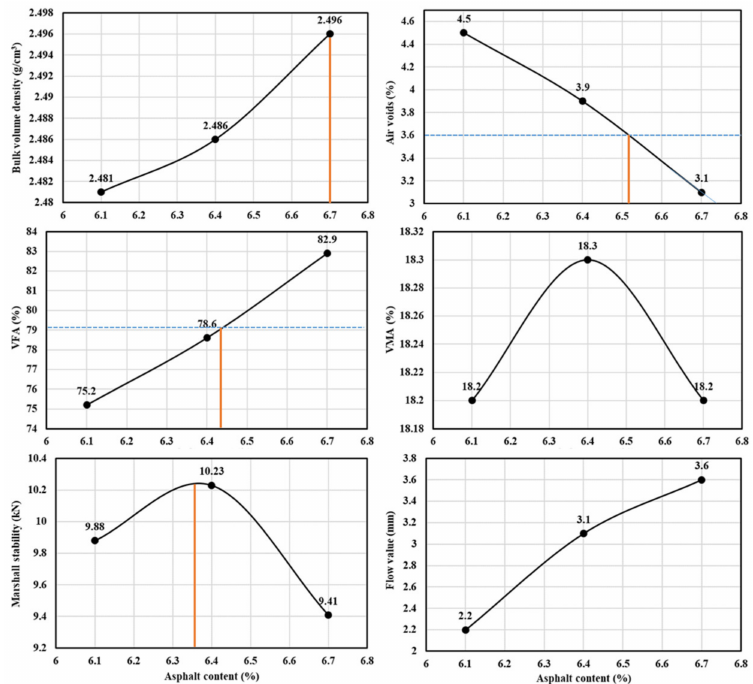
Figure 7. Marshall test results with different asphalt